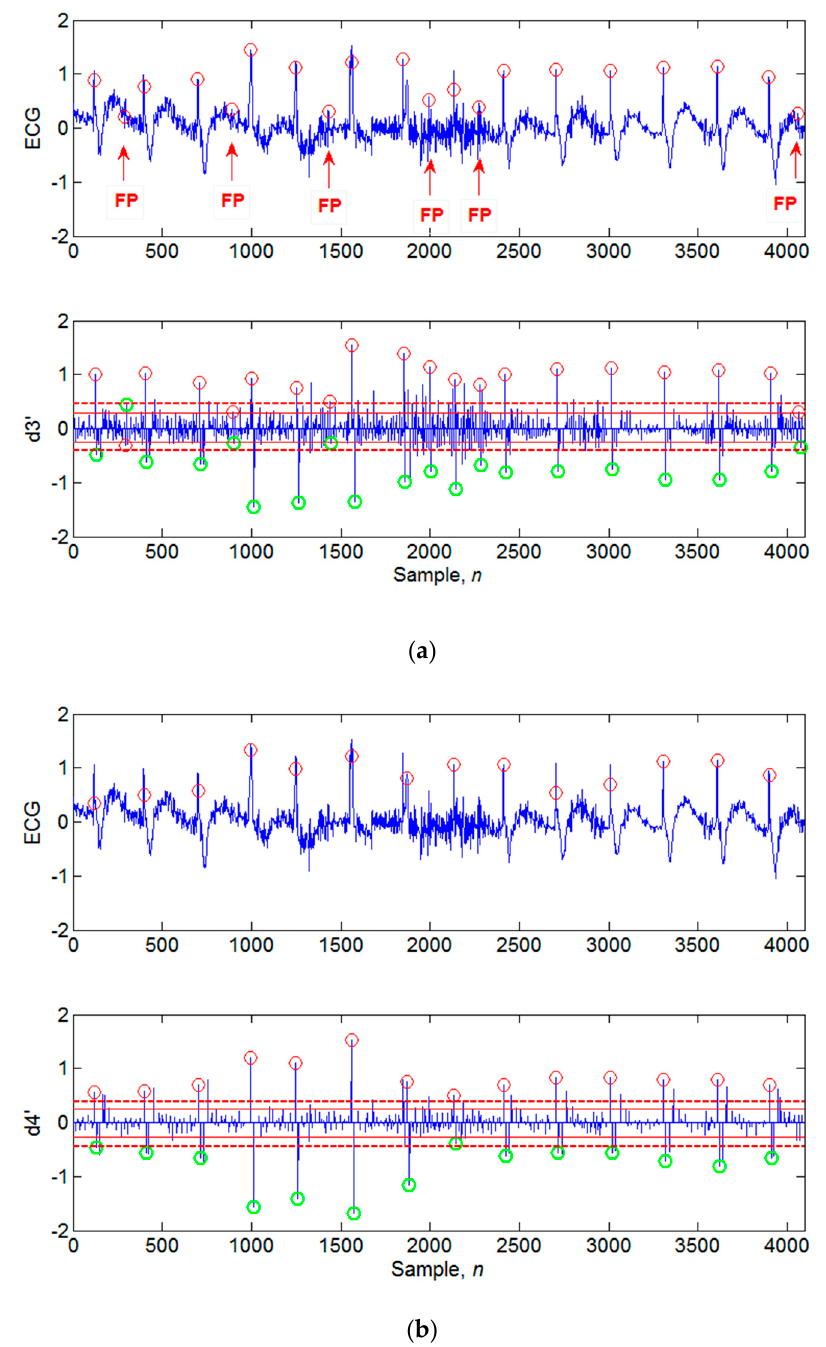
Figure 8. Illustration of the QRS detection results for a noisy ECG signal using ( a ) d3’ and ( b ) d4’.